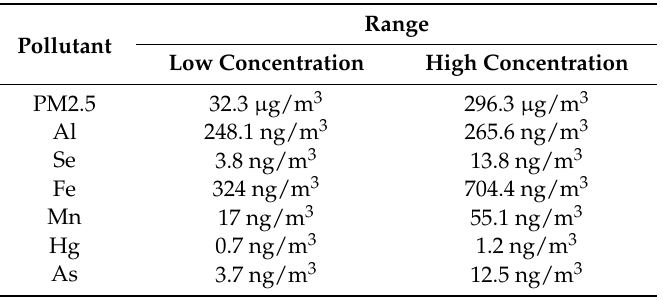
Table 1. Air-quality monitoring